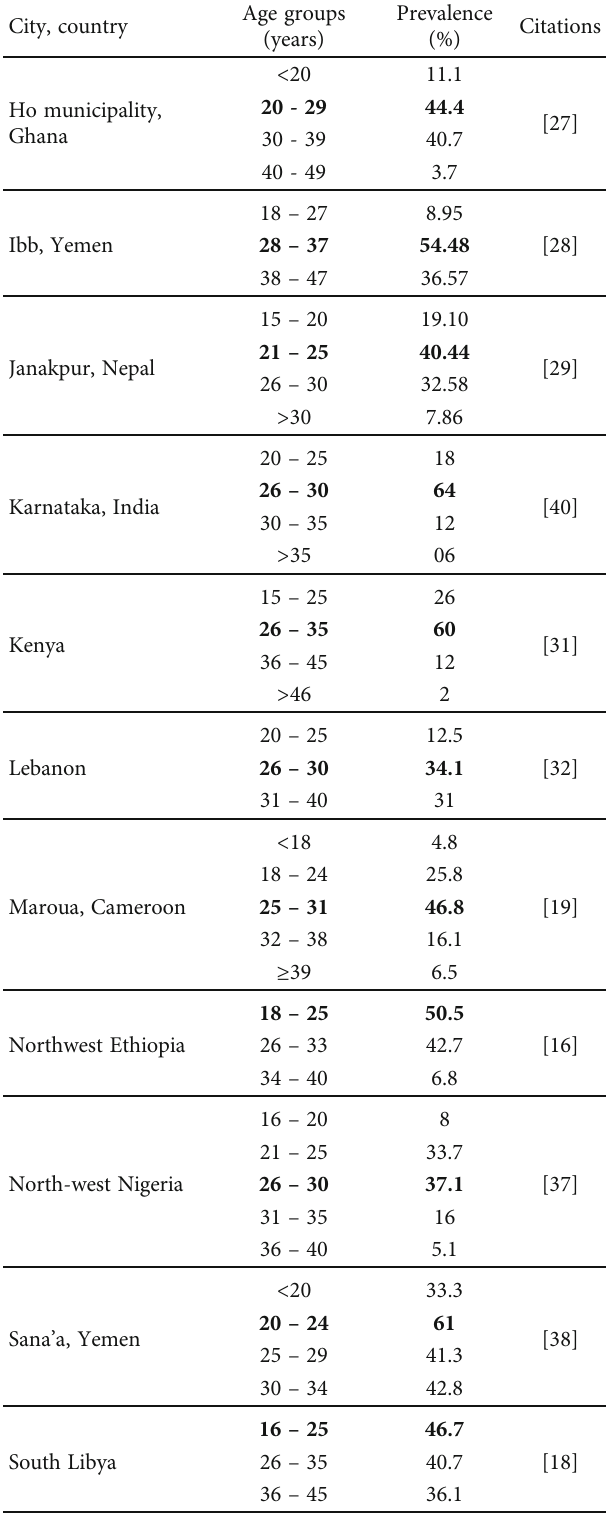
Table 4: Prevalence of VVC among pregnant women according to their age in di ff erent studies. The age groups with the highest prevalence in respective studies are in bold form. Abbreviation: VVC= vulvovaginal candidosis.